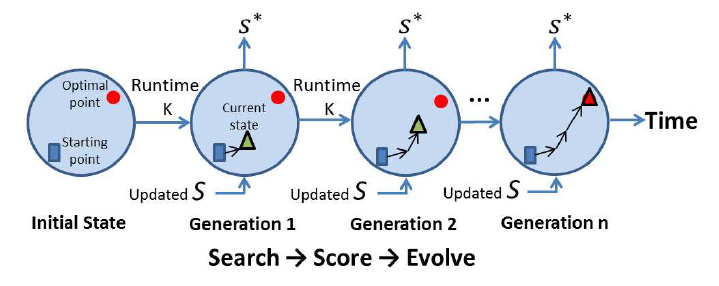
Figure 5. The self-learning process